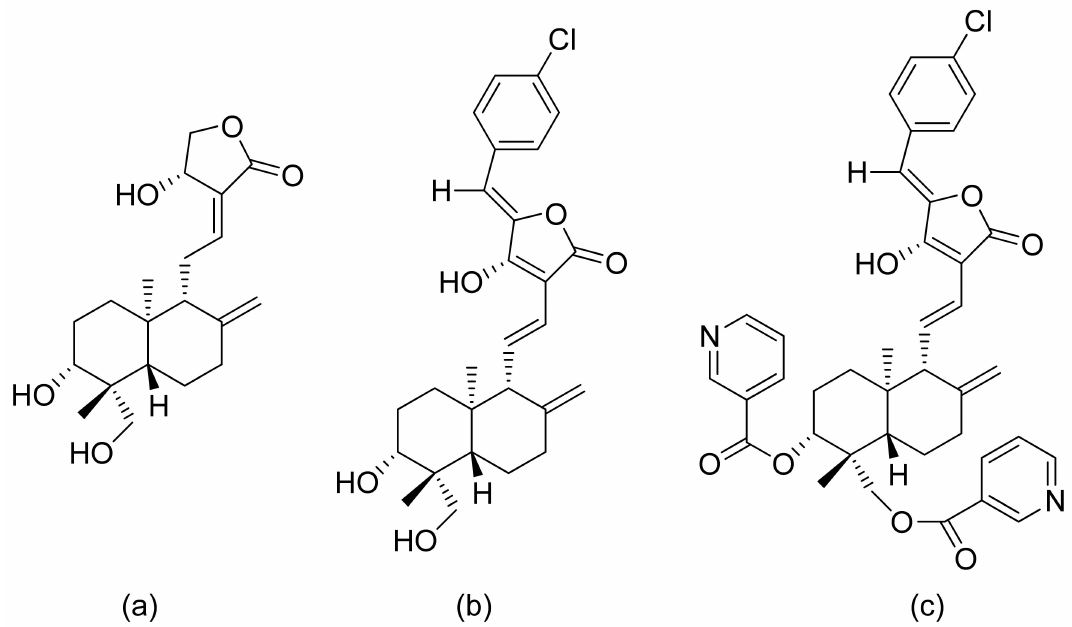
Figure 12. Andrographolide ( a ) and its derivatives ( b , c ).